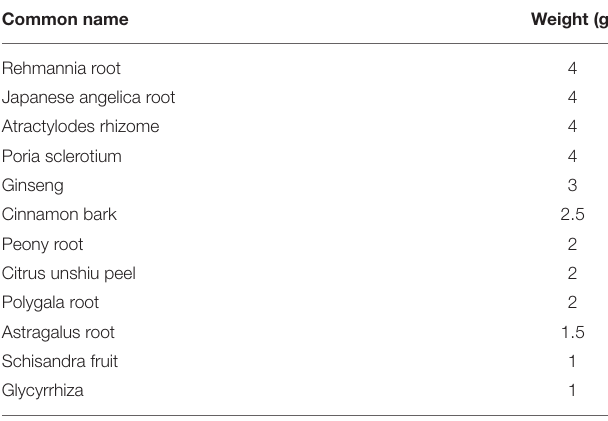
TABLE 1 | Medicinal herb composition of